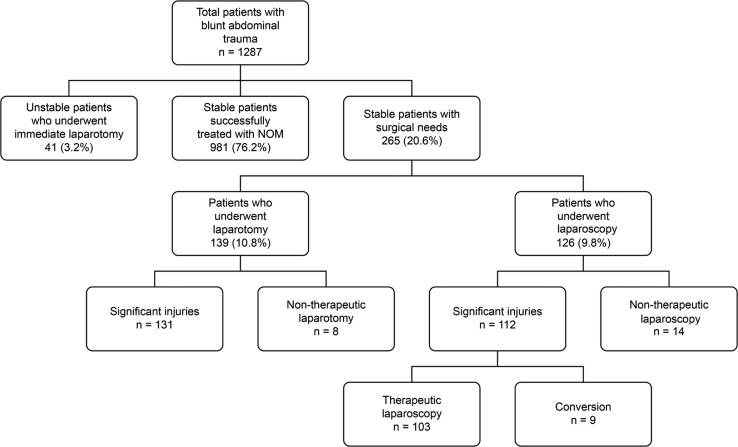
Patient summary flow chart.